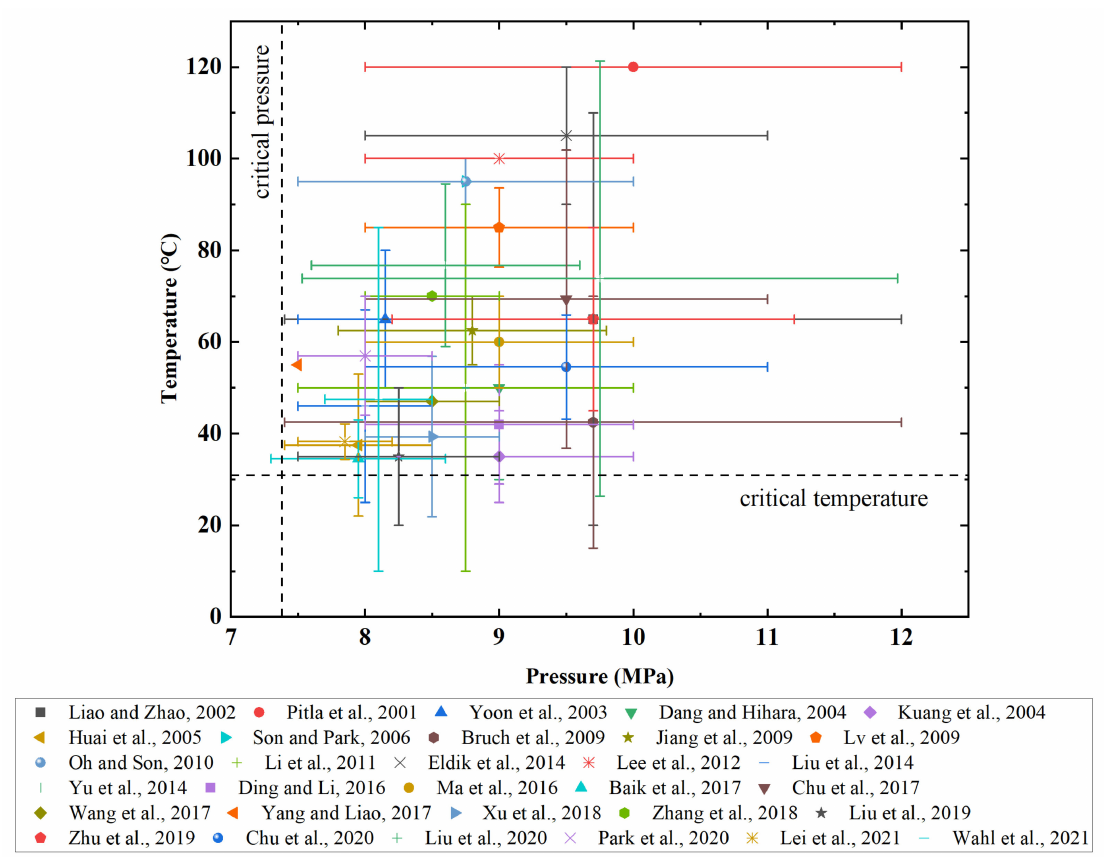
Figure 4. Operating ranges of SCO 2 cooling experiments (detailed parameters of the experiment are shown in Table 1).